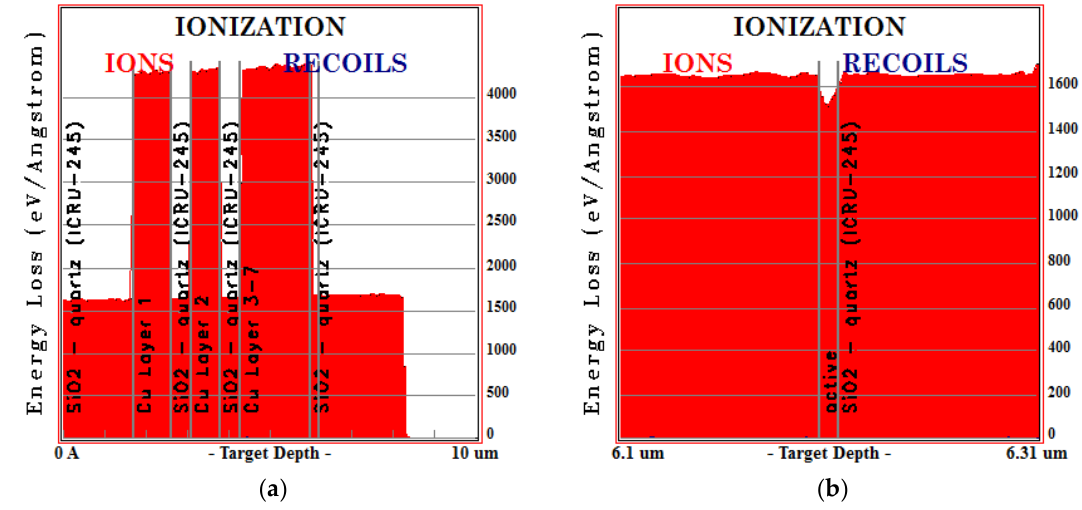
Figure 23. Effective LET in the different layers of the DUT for Xenon (refer FIB cross section of Figure 4). ( a ) shows the long track of the ion stopping power and ( b ) a detailed view on the active silicon area of the DUT.